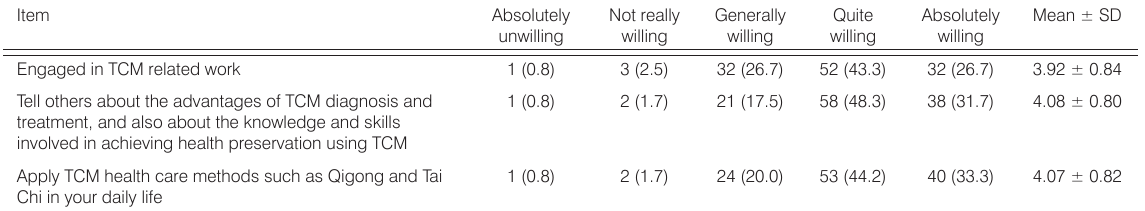
Table 7. Personal behaviors related to TCM ( n ,